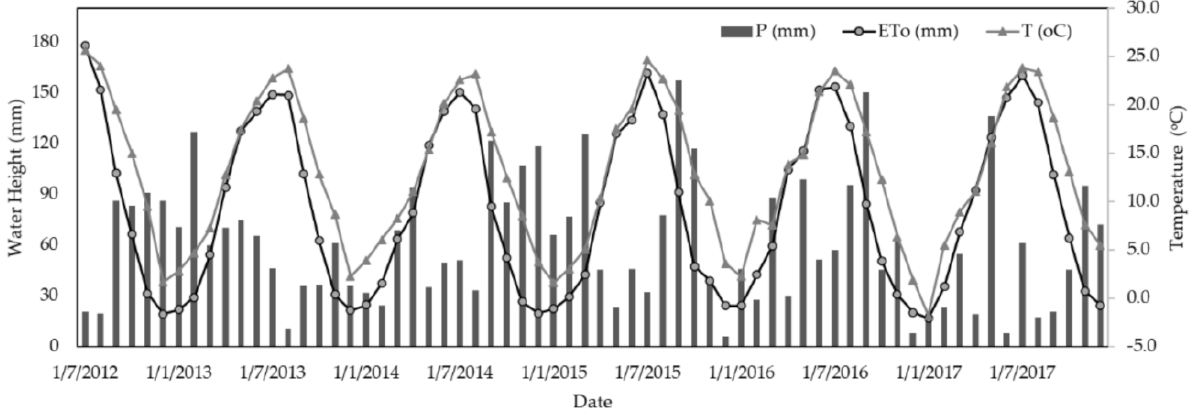
Figure 2. Monthly precipitation, reference evapotranspiration, and temperature of Zazari basin for the period from July 2012 to December